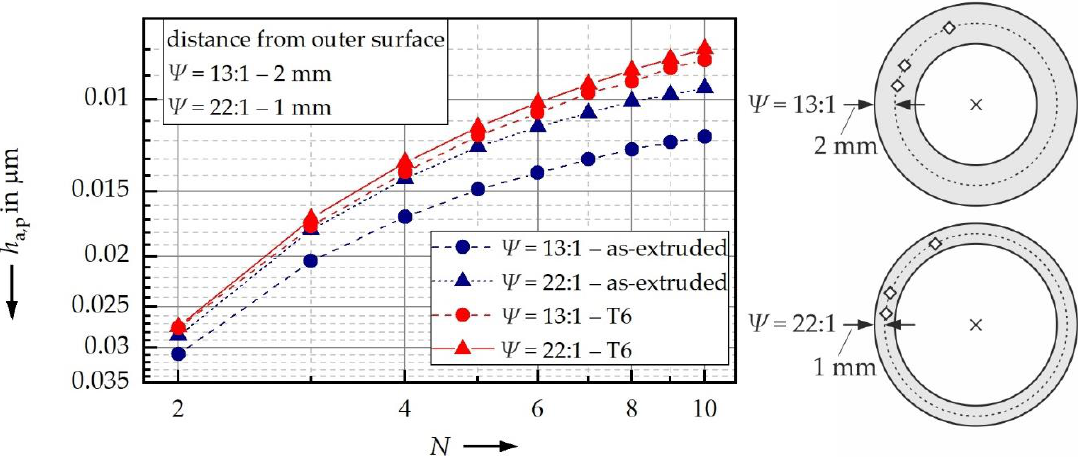
Figure 4. The h a,p - N curves of specimens with extrusion ratios Ψ of 13: 1 and 22:1 in as-extruded state as well as after T6 heat treatment obtained in CITs in the center of the specimens’ wall sections.